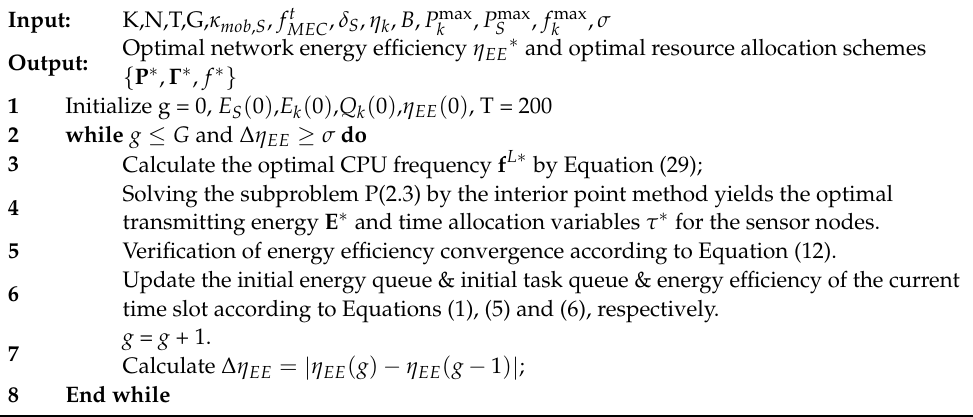
Algorithm 1: Lyapunov-based Joint Online Optimization Algorithm for Partial Task Offloading Decisions and Resource